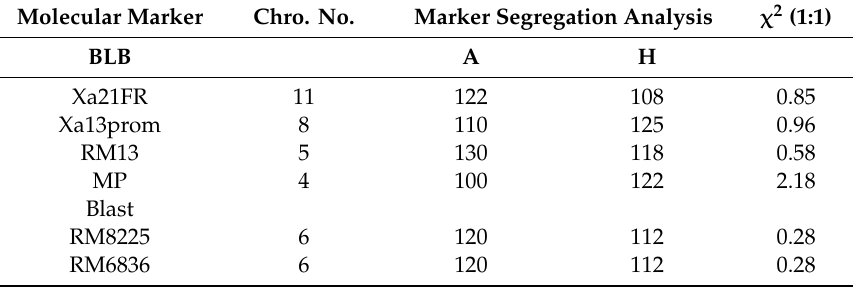
Table 1. Foreground marker segregation analysis of the BC 1 F 1 progenies. Molecular Marker